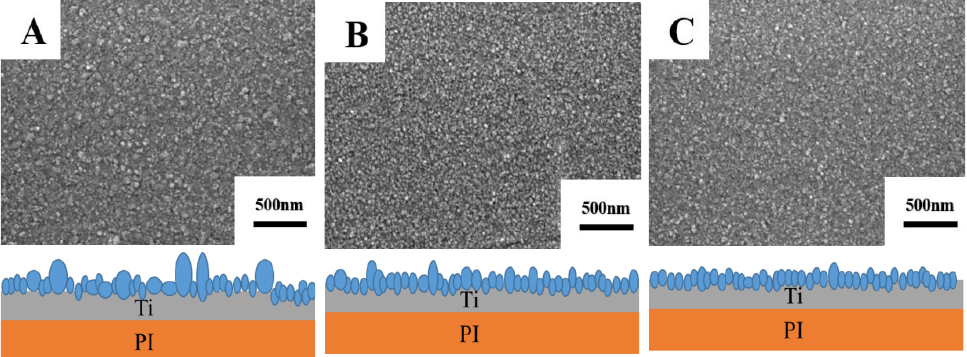
Figure 3. Surface morphologies of films prepared from Ti targets with different purities. ( A ) Target A; ( B ) Target B; ( C ) Target C.